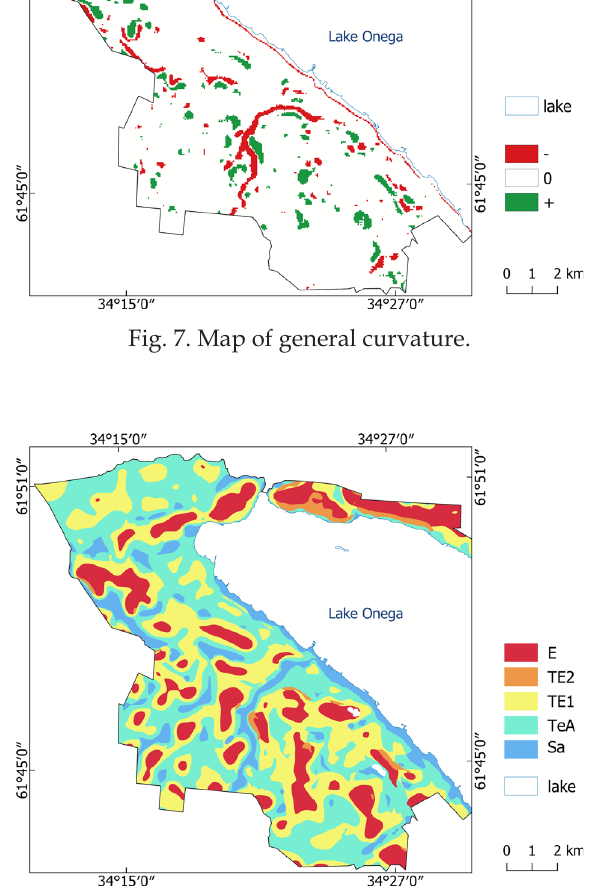
Fig. 5. The ratio of relief classes when changing the estimated radius of the environs.